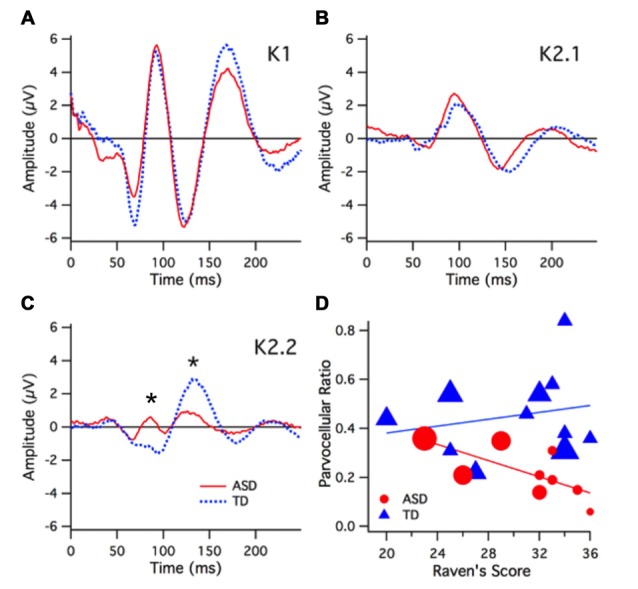
High (96%) contrast nonlinear visually evoked potentials (VEPs) group kernel responses and interactions. Color key for groups; ASD (red) and TD (blue). In these graphs depicting VEP group average responses the positive (P) peaks are in the up direction and negative (N) peaks are in the down direction. (A) The earliest first order kernel cortical activity (N60) shows a smaller mean amplitude for ASD vs. TD (not significant). (B) The second order kernel first slice (K2.1) was not different between ASD and TD groups. (C) The second order, 2nd slice nonlinearity (K2.2) was significantly smaller in amplitude for the ASD group compared with TD at P1 (90 ms) peak (p < 0.006) and P2 (130 ms) peak (p < 0.05) and as indicated by asterisk. (D) Parvocellular nonlinearity ratio (estimated for the major P130 peak) diminishes as a function of Raven’s score for the ASD but not TD group. The marker size here represents global IT. A three-way relationship is evident in the diminishing marker size (shorter IT) as Raven’s score increases for the ASD but not the TD group.